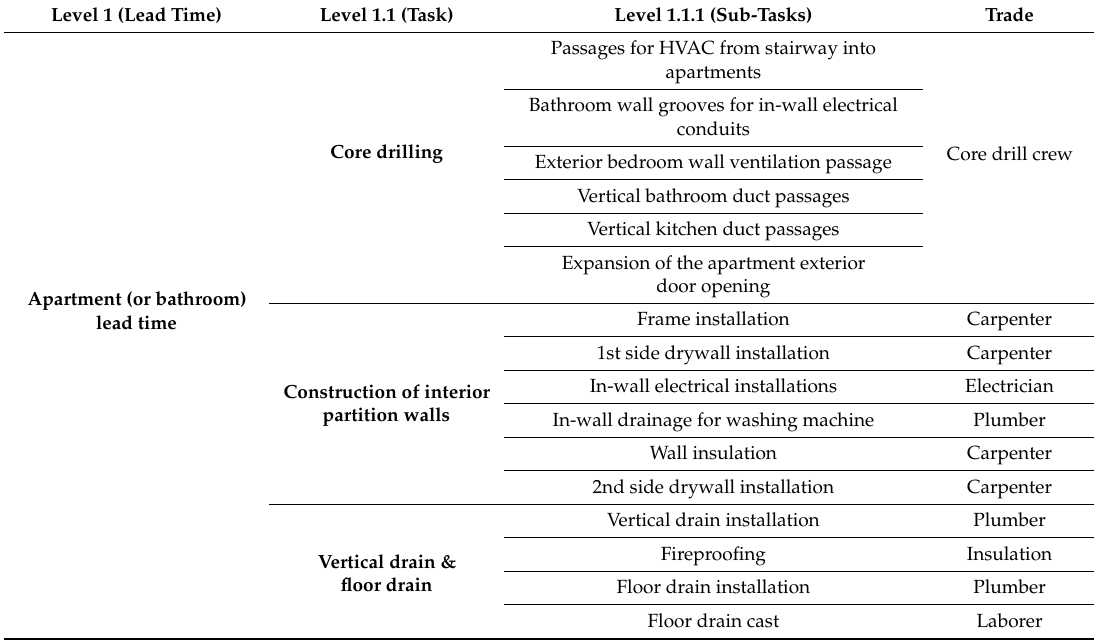
Table 4. The production process can be defined on di ff erent levels of detail. Precise planning defines the trade sequence and the trades required in